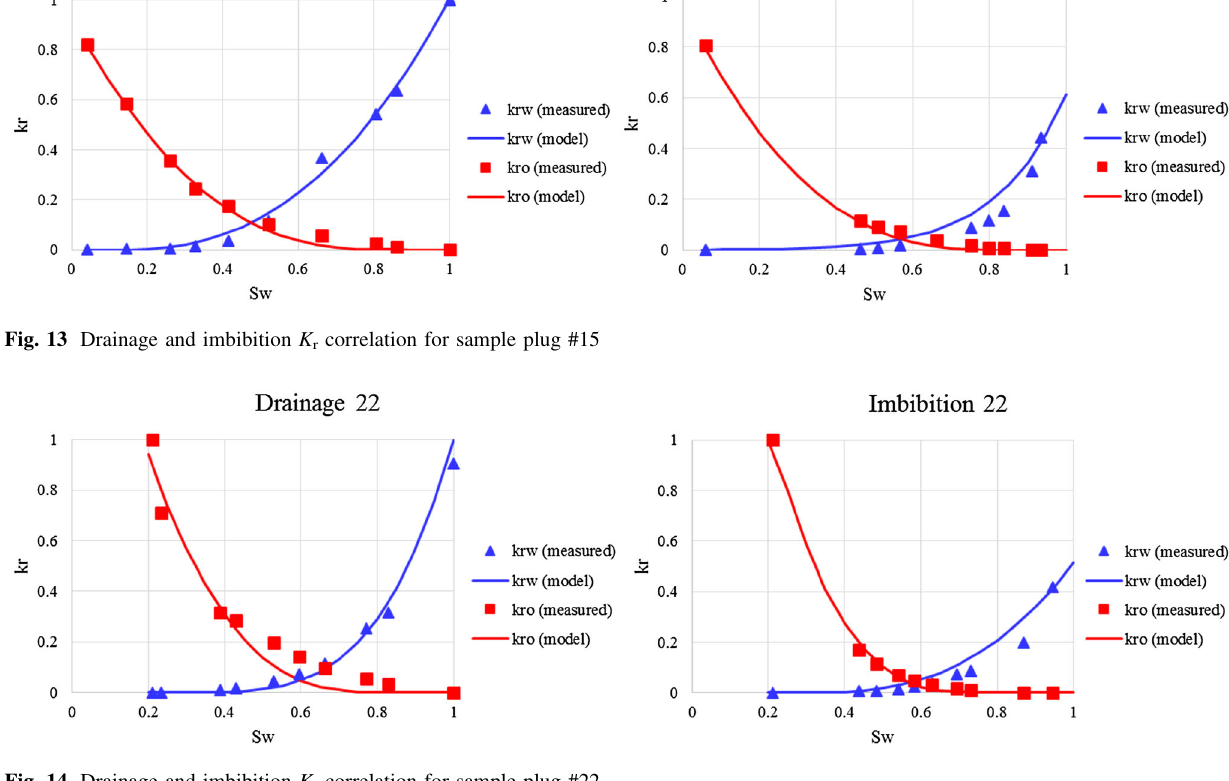
Fig. 14 Drainage and imbibition K r correlation for sample plug #22